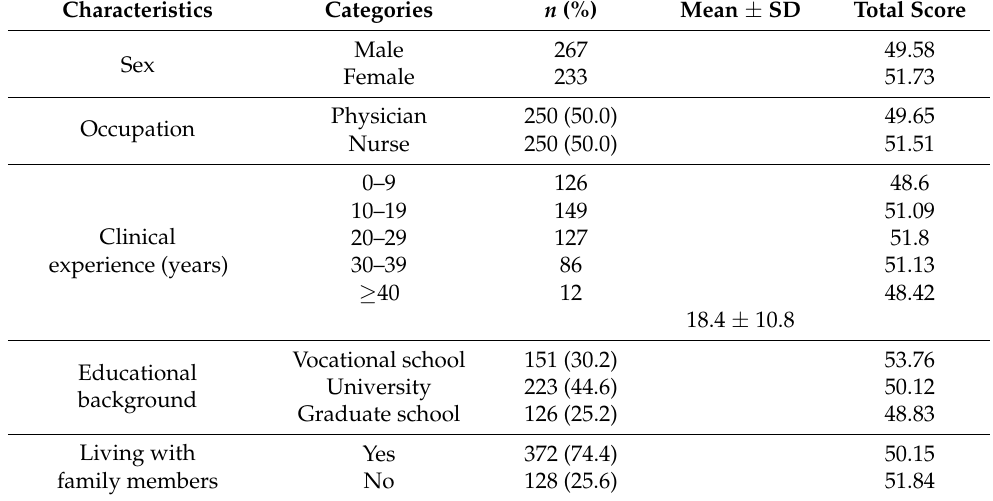
Table 1. Participant characteristics ( n =